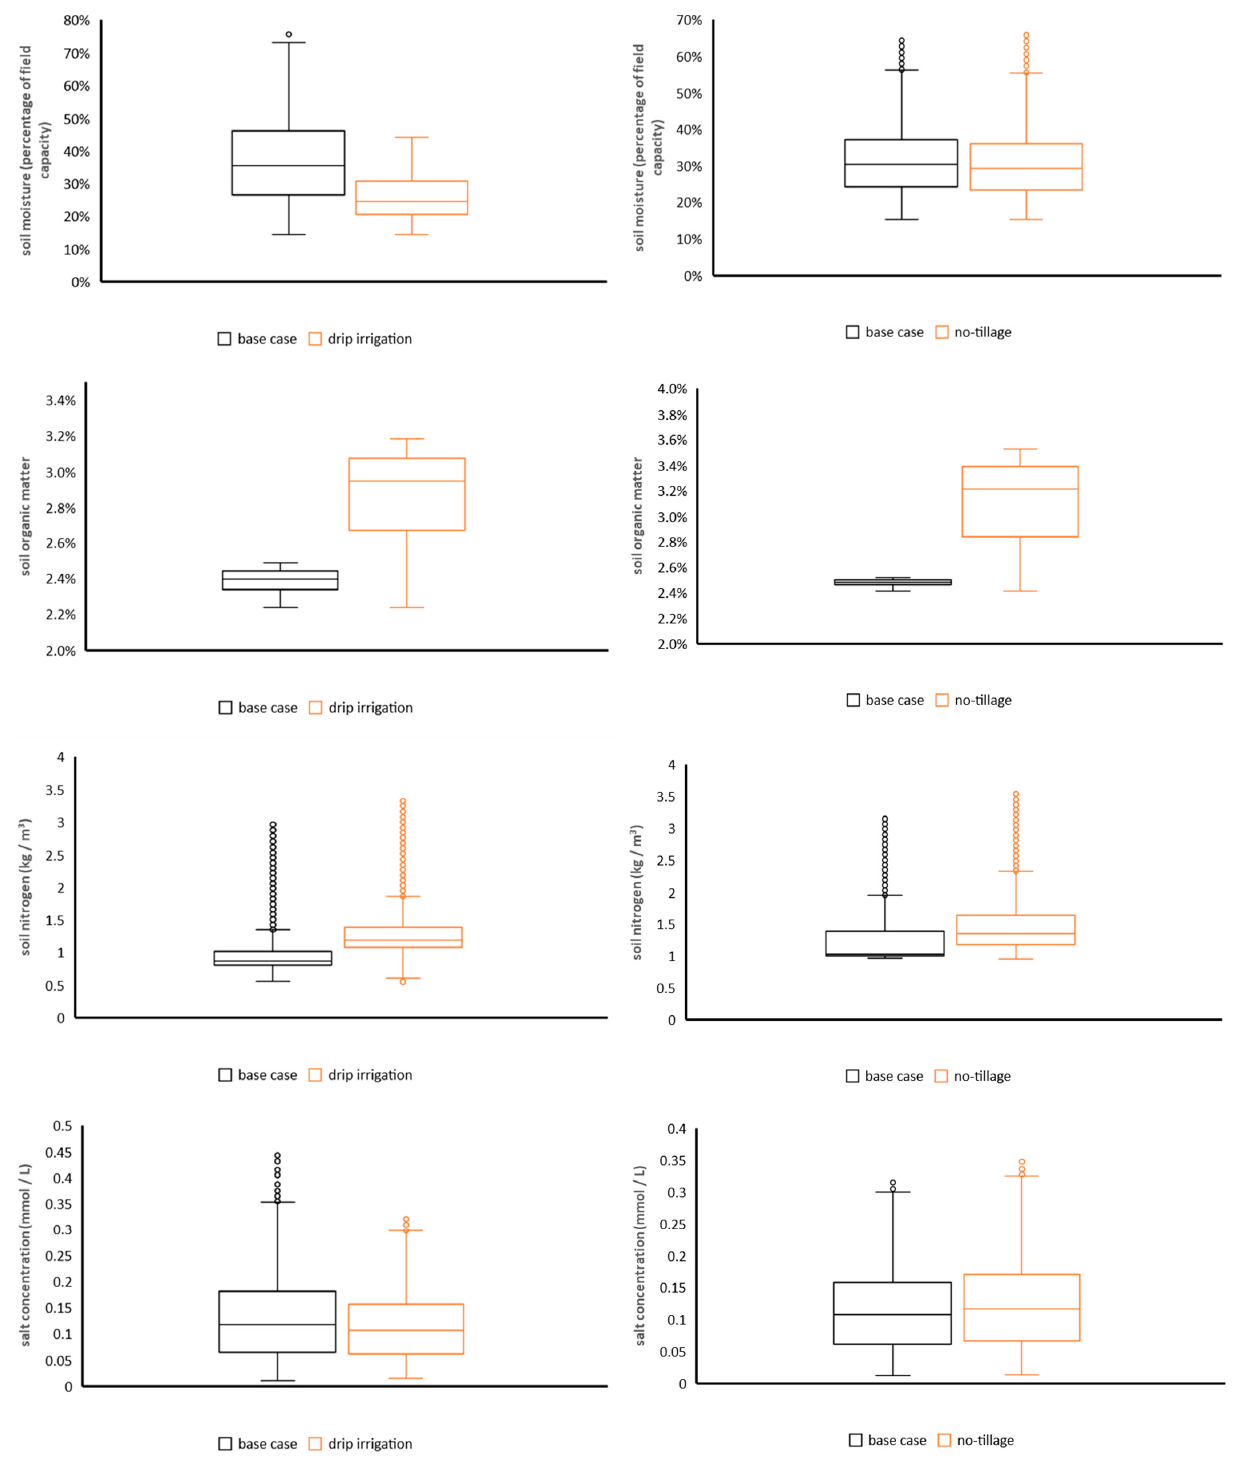
Figure 11. Summary of biogeochemical dynamics from both drip irrigation ( left column) and no-tillage ( right column) experimental simulations.